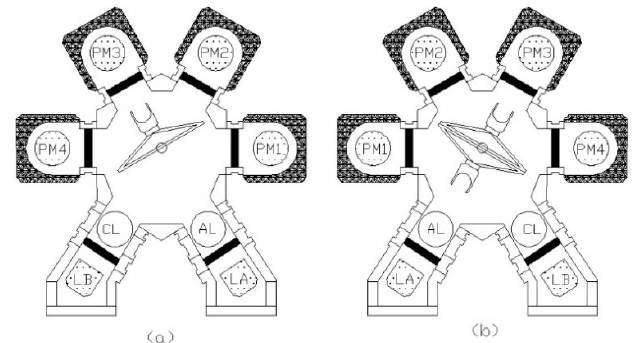
Figure 1. Cluster tools: ( a ) single-arm robot and ( b ) dual-arm robot.